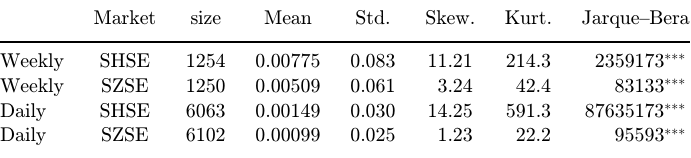
Table 1. Descriptive statistics of weekly and daily average returns for the SHSE and SZSE stocks. The Jarque – Bera statistics are presented in the last column